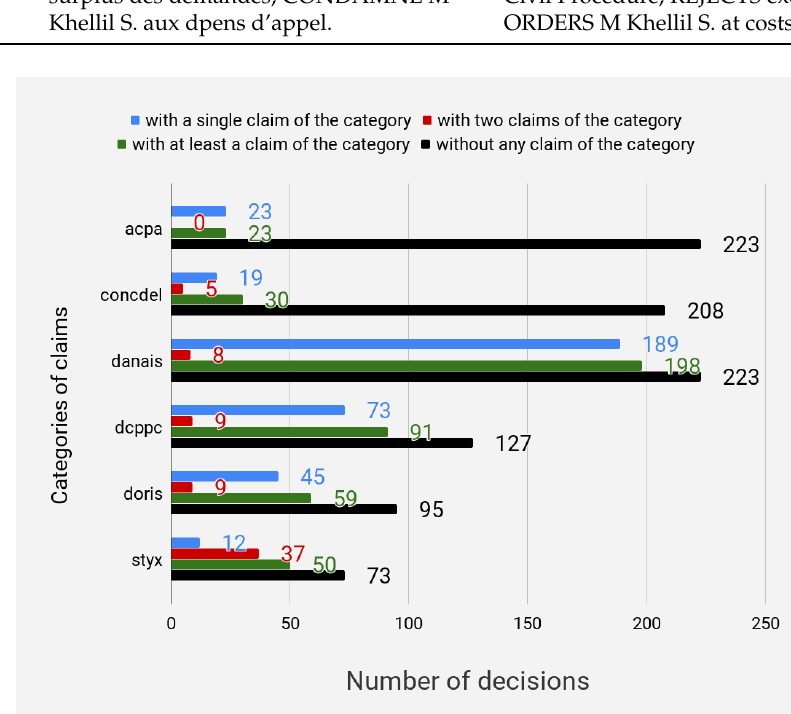
Figure 1. Number of claims in